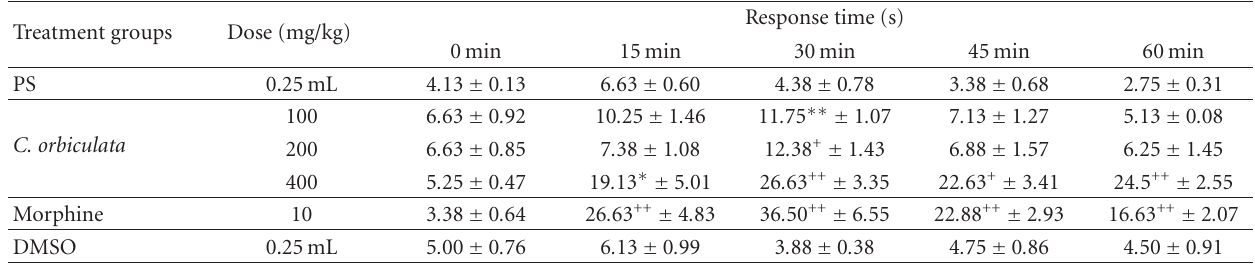
Table 2: E ff ect of leaf methanol extract of Cotyledon orbiculata on hot-plate-induced nociception in mice. Treatment groups